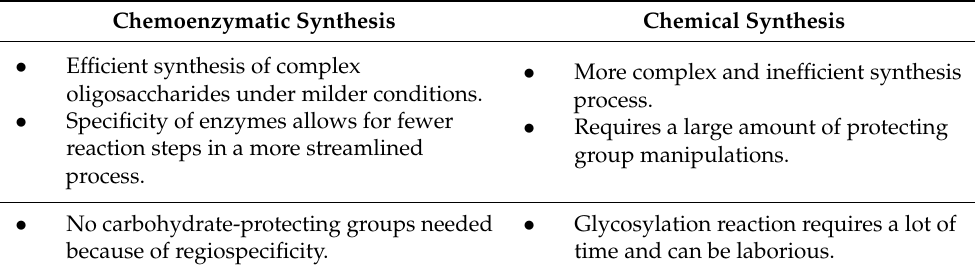
Table 1. Differences of chemoenzymatic and chemical